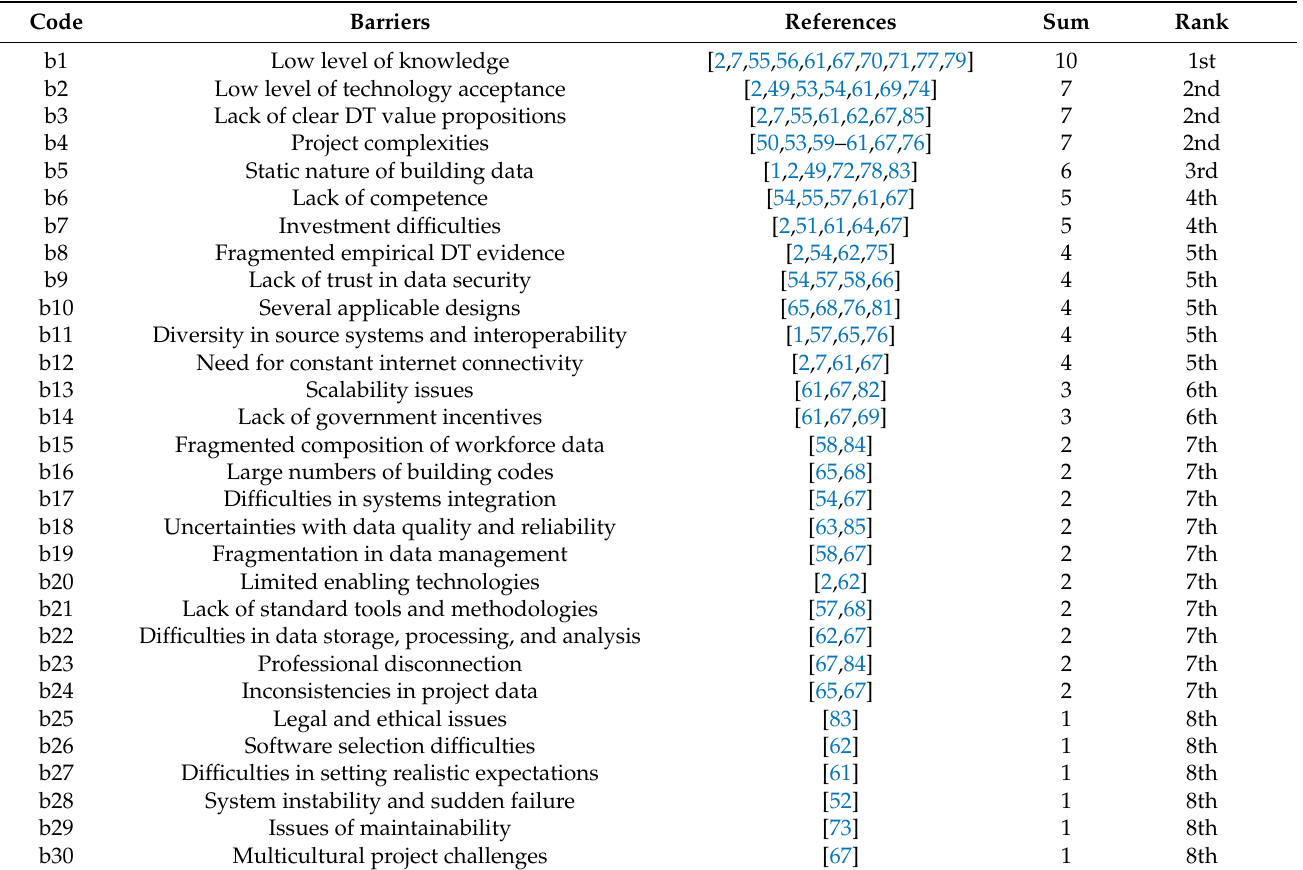
Table 6. Barriers to the adoption of DT in the